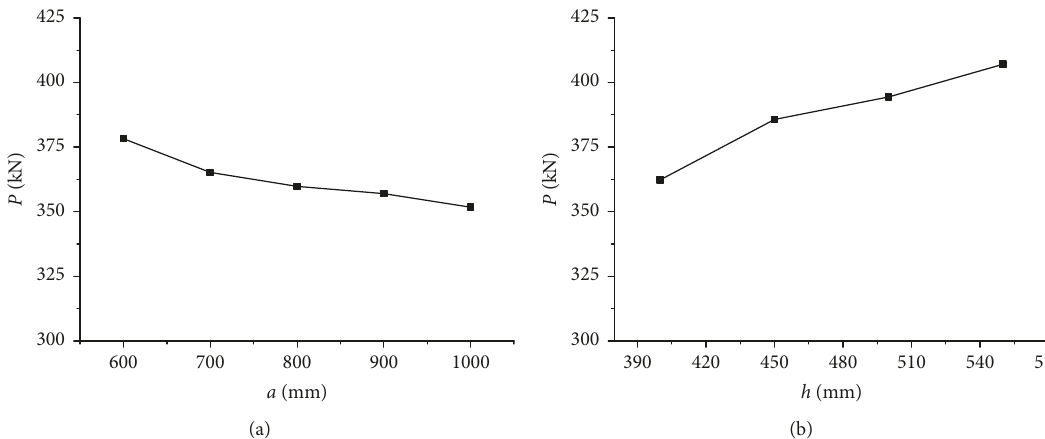
Figure 10: Relationship between shear span ratio and shear capacity. (a) Length of shear span. (b) Section